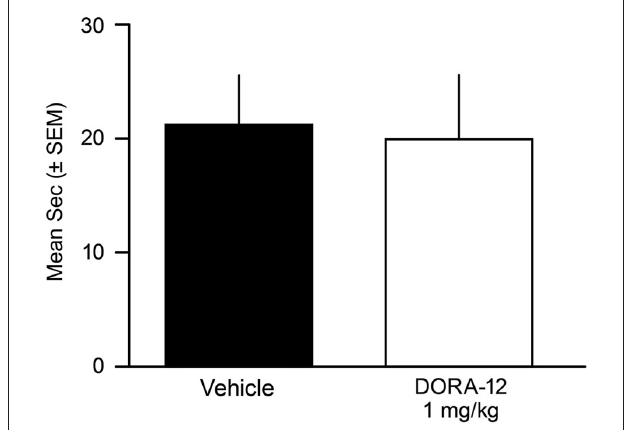
FIGURE 4 | Time to complete Food Elicited Cataplexy Test (FECT) was not affected by high-dose DORA-12. Dogs showed no physical signs of cataplexy (see Babcock et al., 1976) and there was no difference in the mean duration (seconds/dog/2 tests ± SEM) to complete FECT on vehicle (20% Vitamin E TPGS; black) compared to the same dogs ( n = 11) with high-dose DORA-12 (1 mg/kg, 100x minimum efficacious sleep dose; white) tested at peak